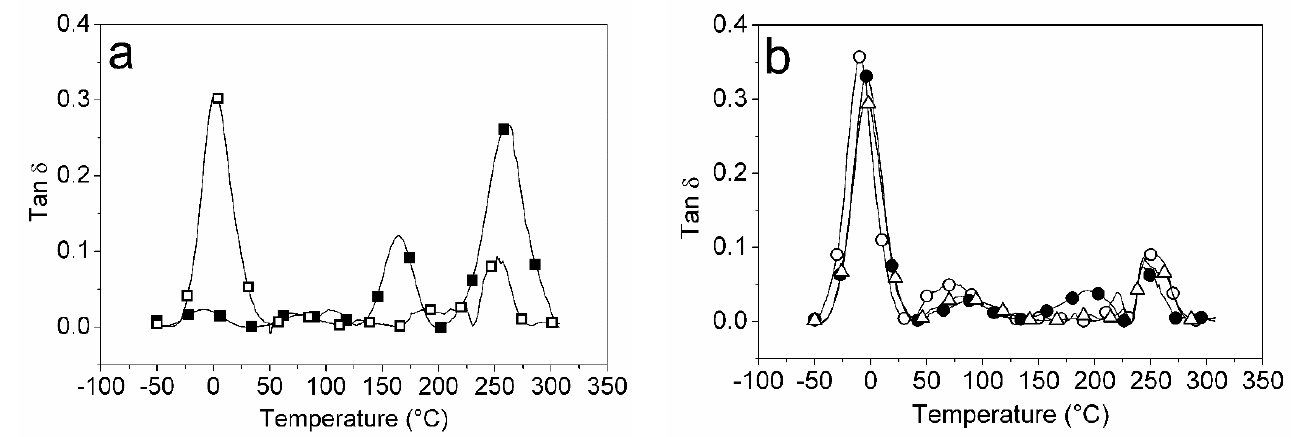
Figure 7. Variation of tan d with temperature for films: ( a ) F0/0 (full squares) and F5/0 (open squares); ( b ) F5/0.5 (open circles), F5/2 (full circles) and F5/10 (open triangles).